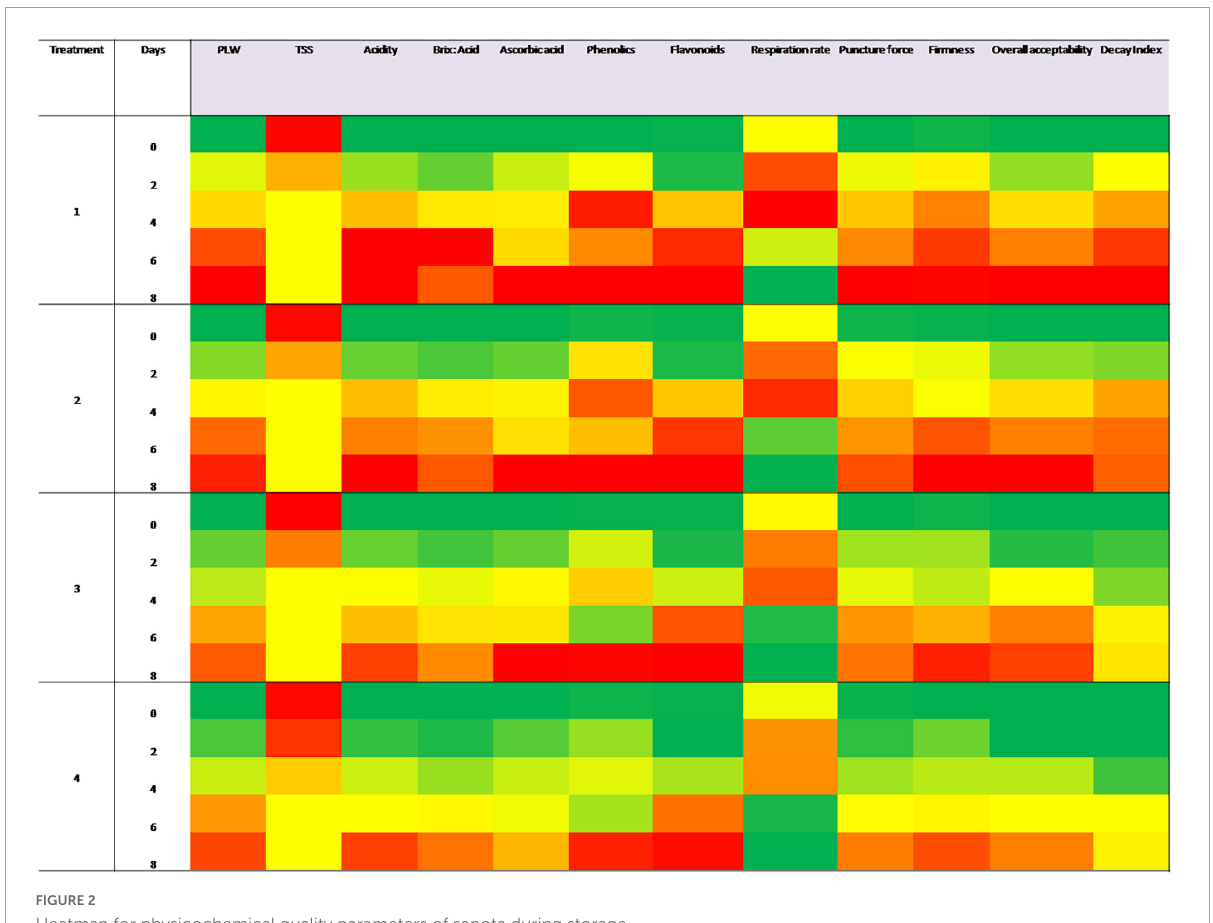
FIGURE2 Heatmap for physicochemical quality parameters of sapota during storage.